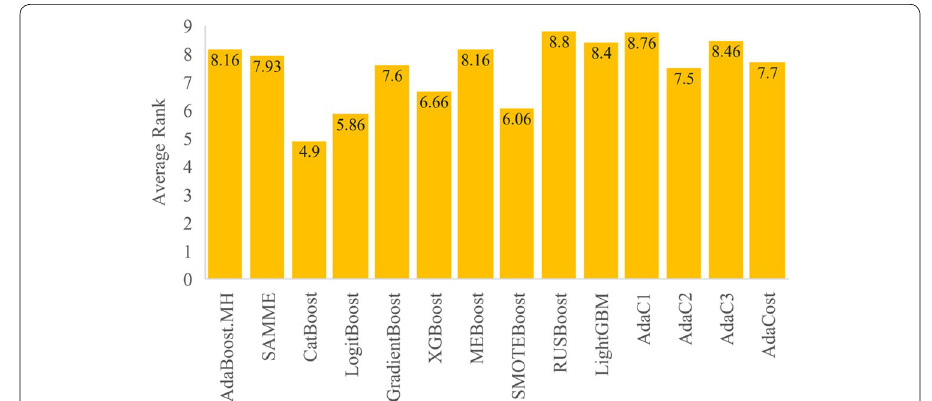
Fig. 4 Average ranks obtained from Friedman test based on the G -mean